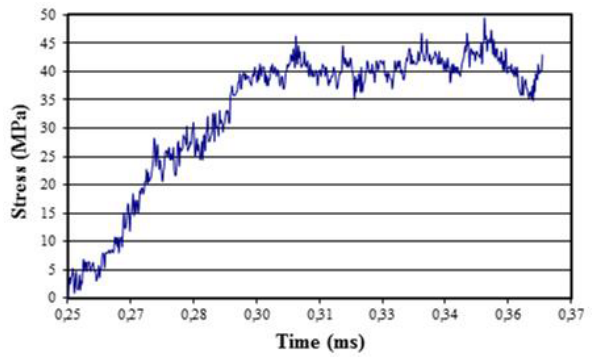
Figure 21. Strain rate to time curve relating to the modified SHTB without the interruption device (Model 2) at a pressure equal to 3.5bar.